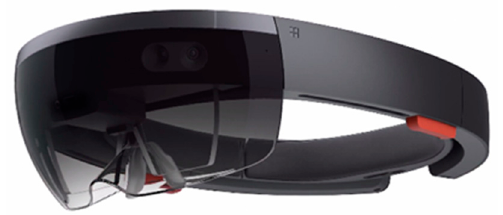
Figure 1. Microsoft HoloLens.